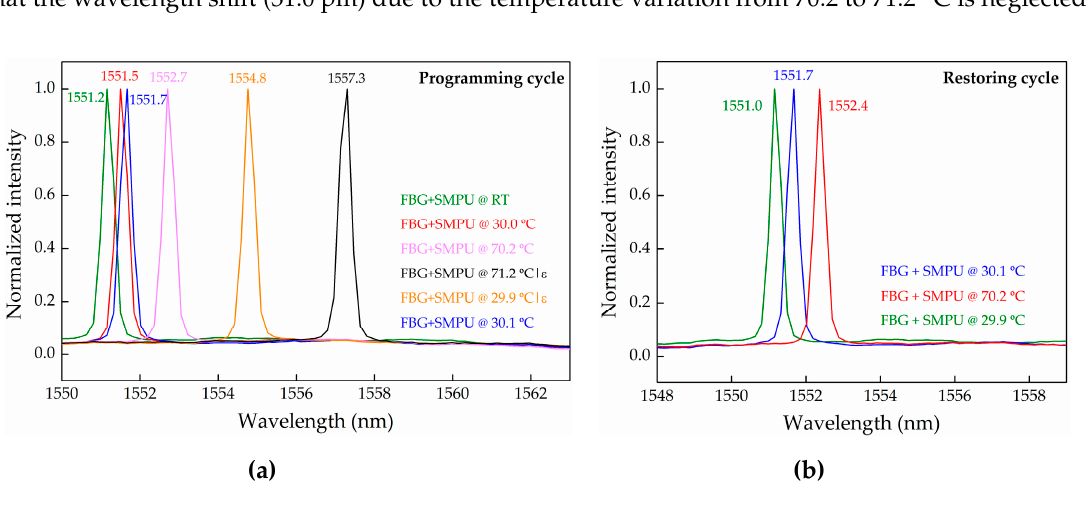
Figure 7. Reflection optical spectra of the FBG+SMPU system along with the ( a ) programming and the ( b ) restoring cycle.